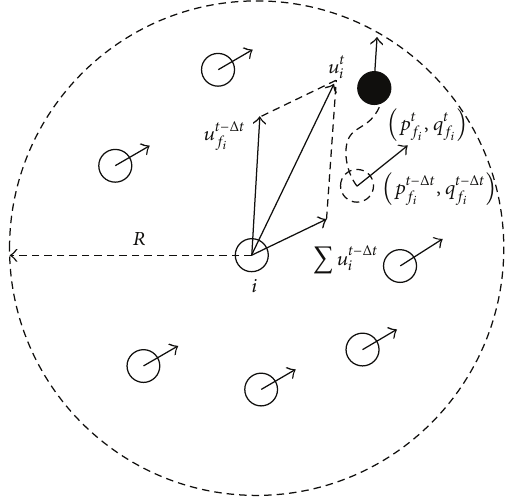
Figure 1: Internal interaction mechanisms of individuals based on “maximum-ICD”